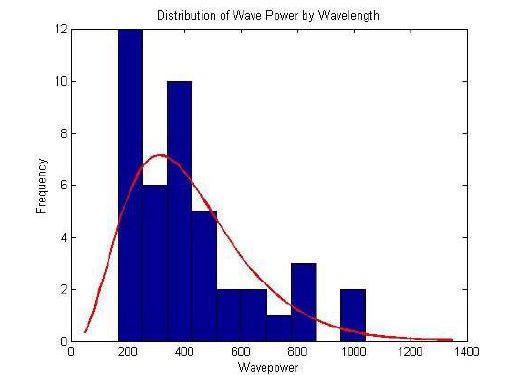
Figure 8. Eq.4 Wave Power Distribution